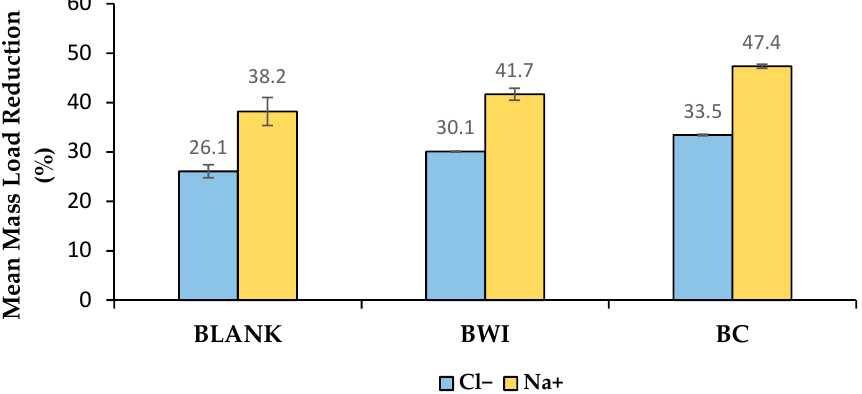
Figure 7. Mean mass load reduction for all storm events and salt concentrations for each column type. Error bars indicate standard error of duplicate measurements (blank: no plants; BWI: Blue Wild Indigo; BC: Broadleaf